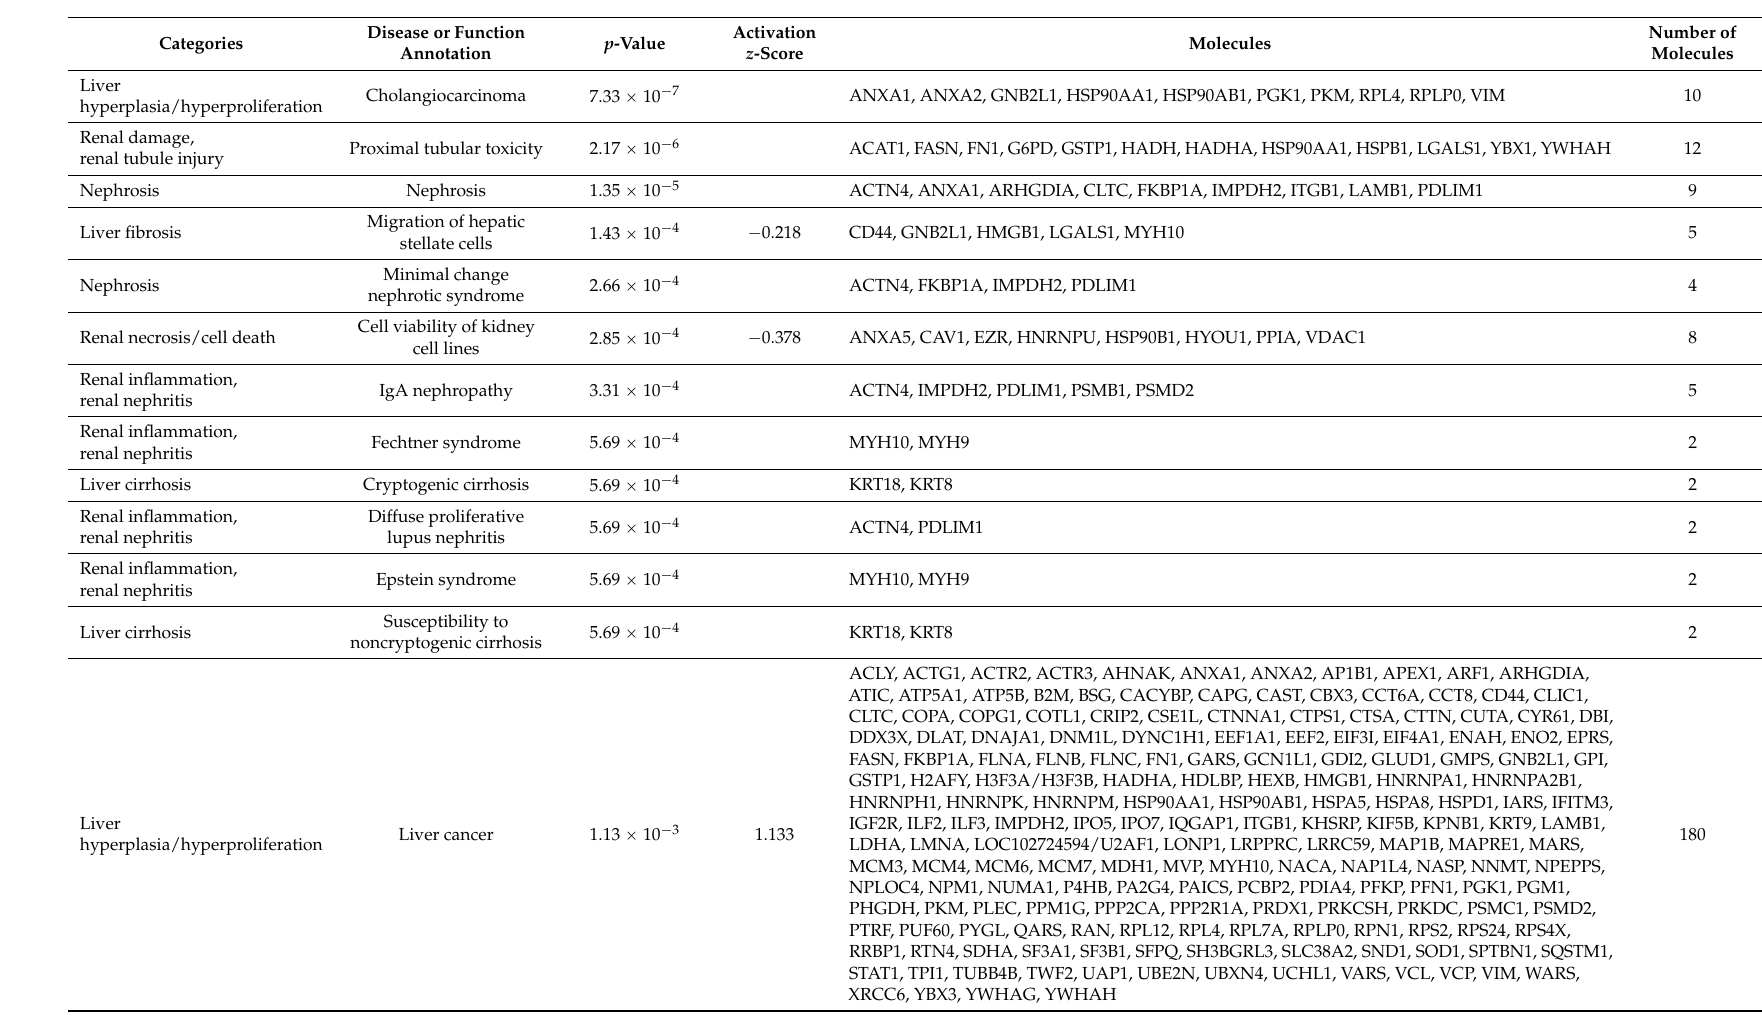
Table 6. 187 categories of vancomycin-associated toxicity analyzed using